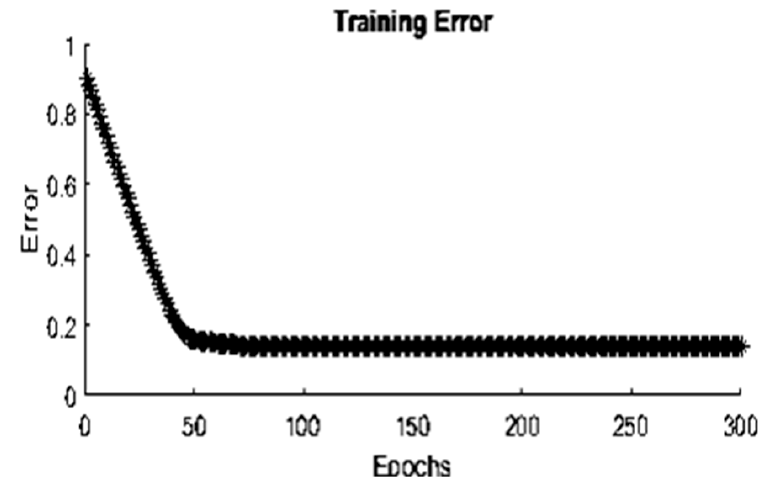
Figure 15. Training error curve of proposed ANFIS control for depth plane.